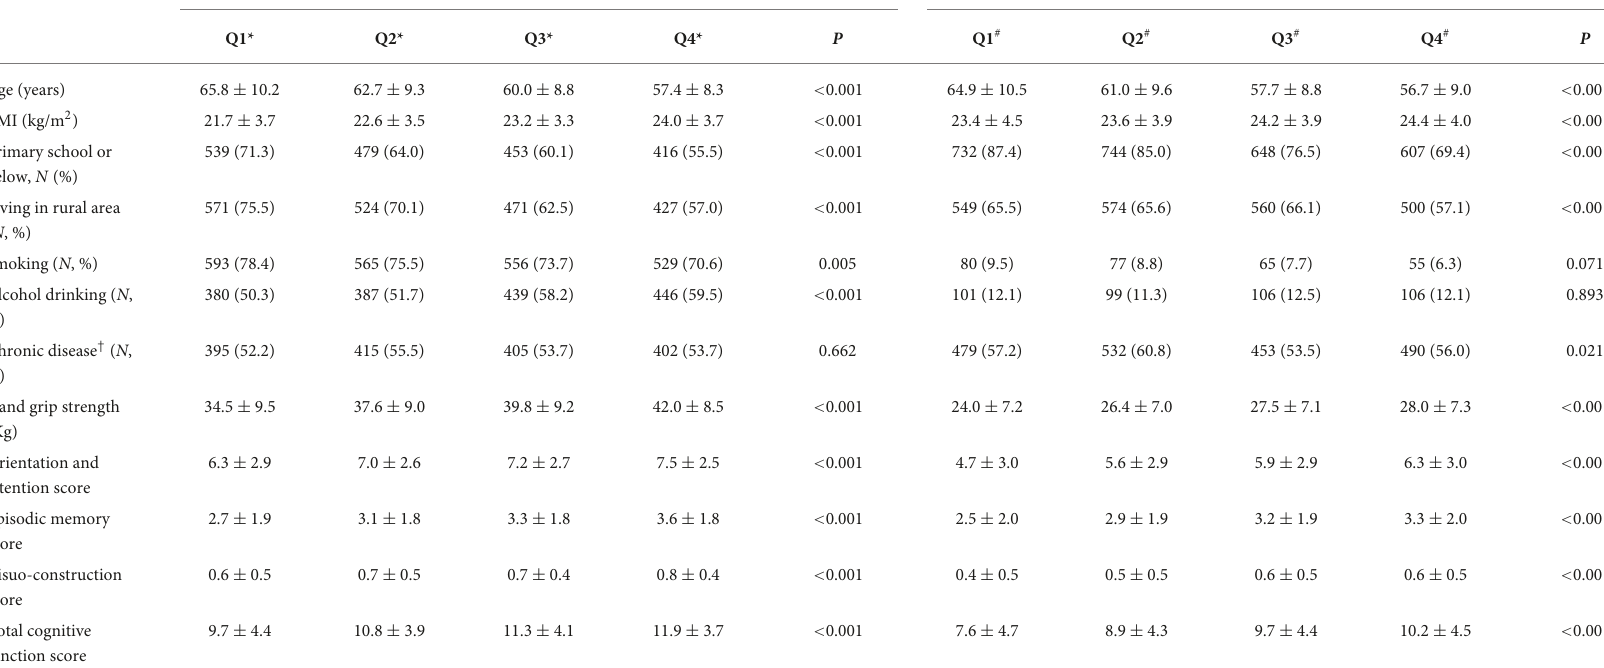
TABLE 2 Characteristics of participants according to SI